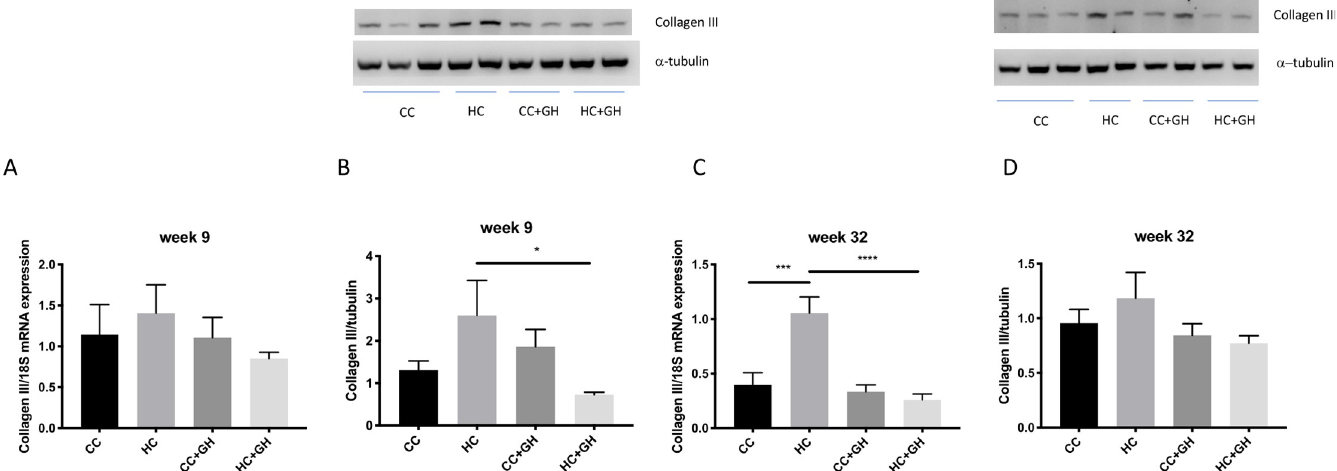
Fig 6. Renal fibrotic changes as measured by collagen III. (A) mRNA expression of collagen III at week 9, (B) western blotting for collagen III at week 9, (C) mRNA expression of collagen III at week 32, (D) western blotting for collagen III at week 32. Results expressed as mean ± SEM, n = 6. � p < 0.05, ��� p < 0.001, ���� p < 0.0001.